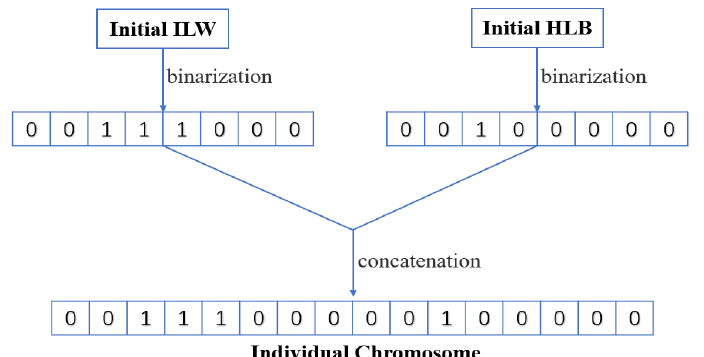
Figure 13. The illustration of the encoding